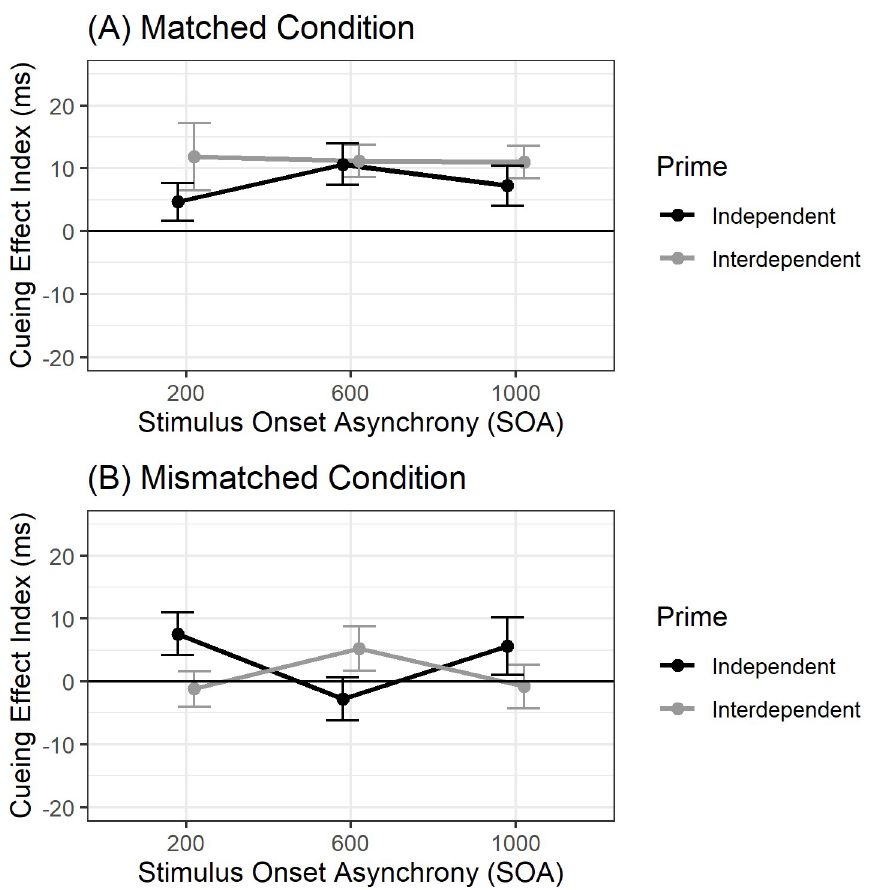
Fig 3. Cueing effects for East Asian Canadians. Note : Cueing Effect Index as a function of SOA and prime for (A) matched and (B) mismatched conditions. Error bars represent standard error of the mean. Participants are East Asian